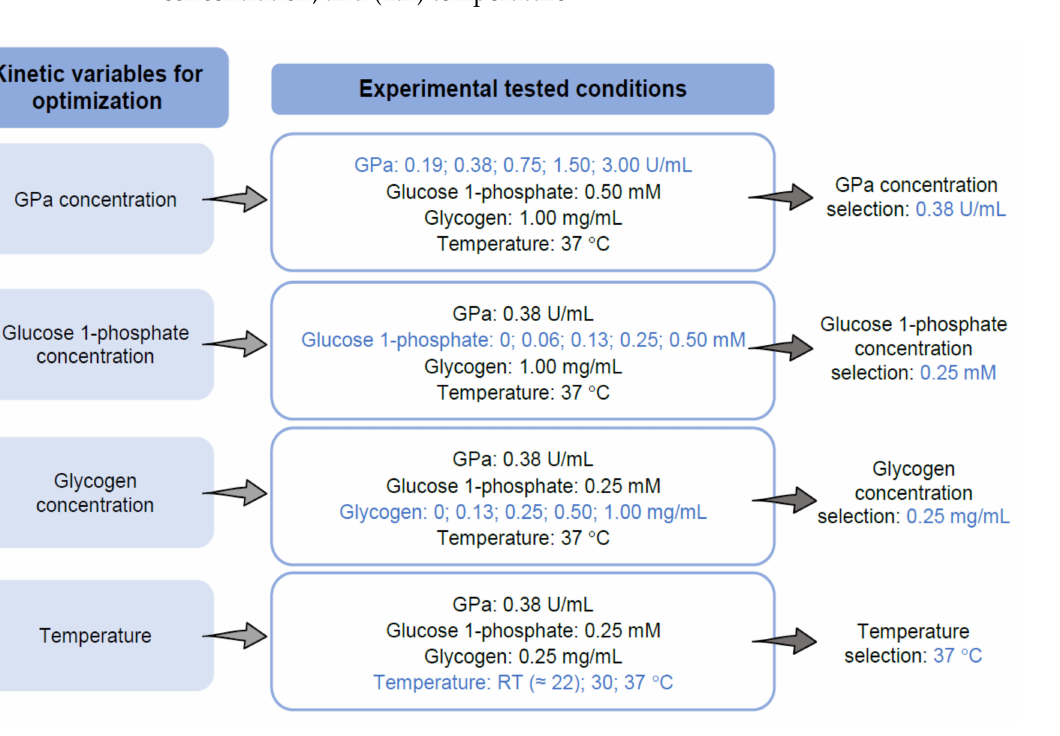
Figure 4. Kinetic variables considered for optimal performance for assessment of the in vitro GPa inhibition assay. RT means room